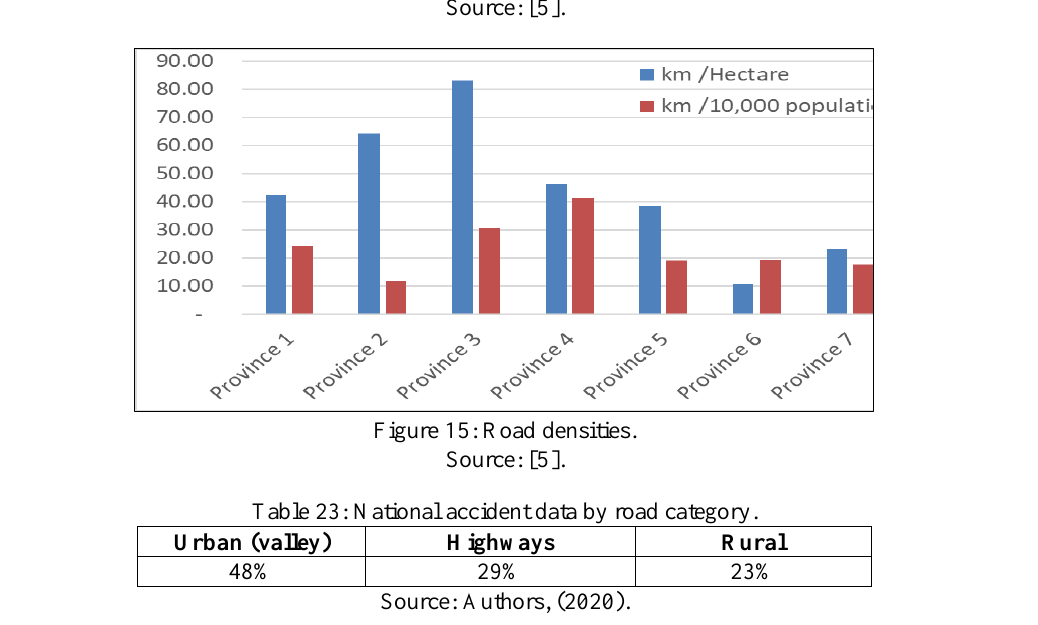
Figure 14: Exposure of risk against road fatality.